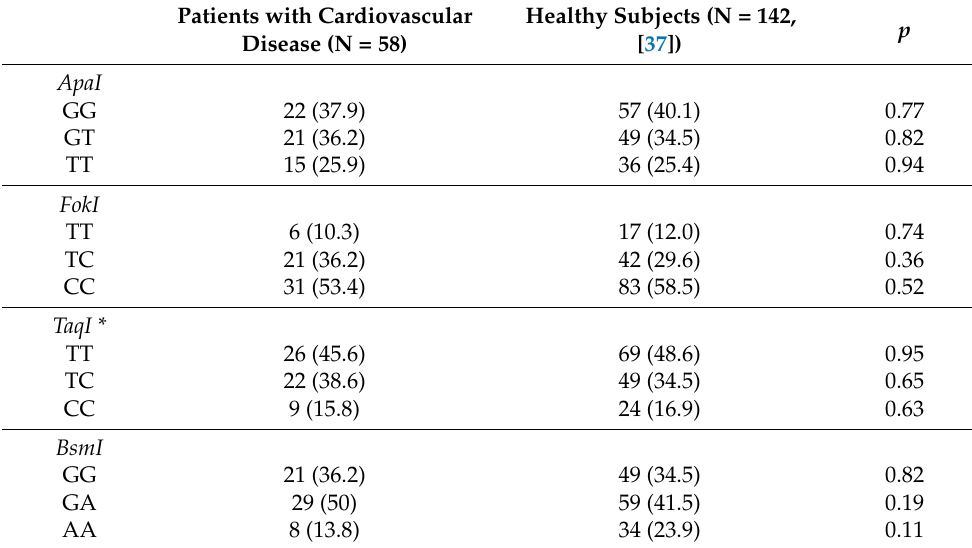
Table 2. Distribution of genotypes (N, (%)).